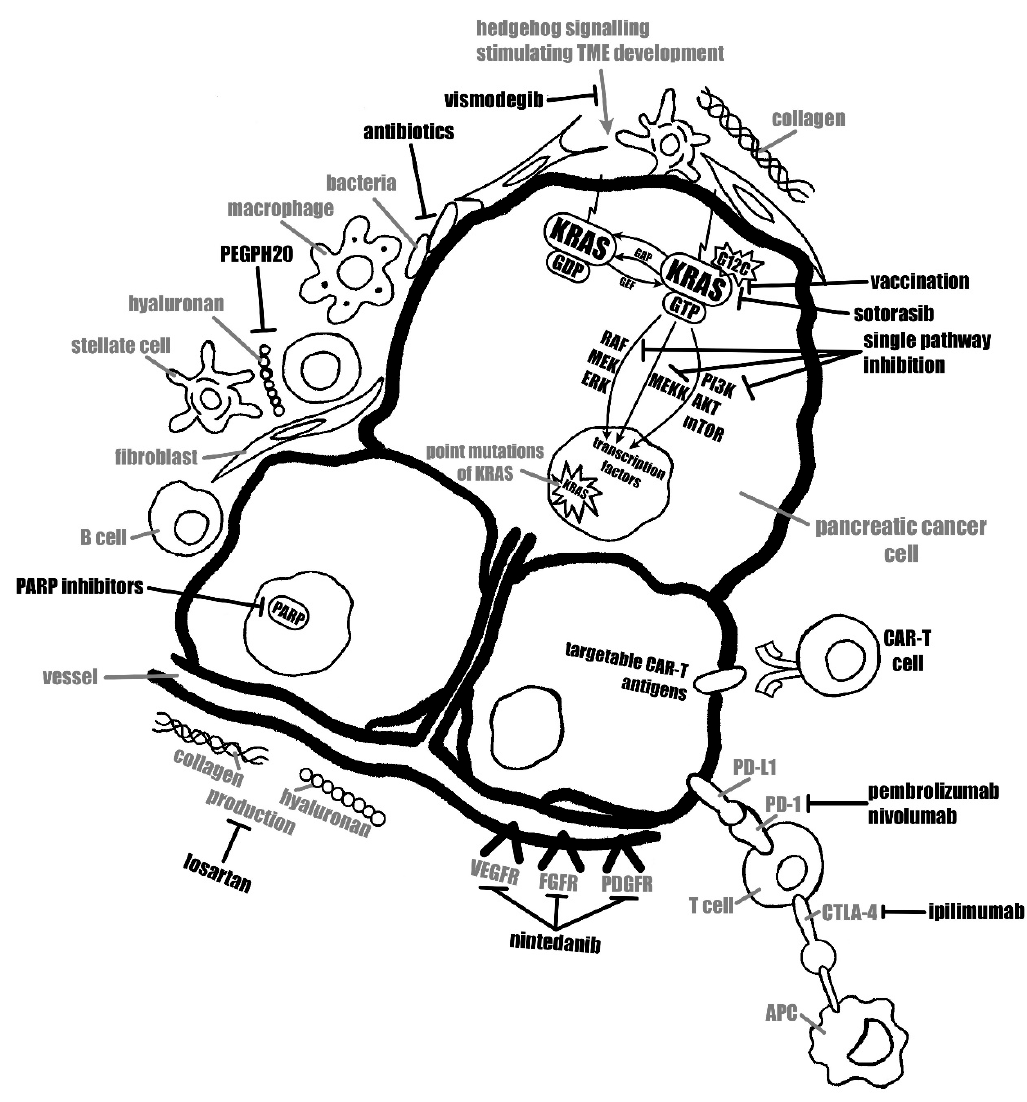
Figure 2. Scheme representing different therapeutic strategies.